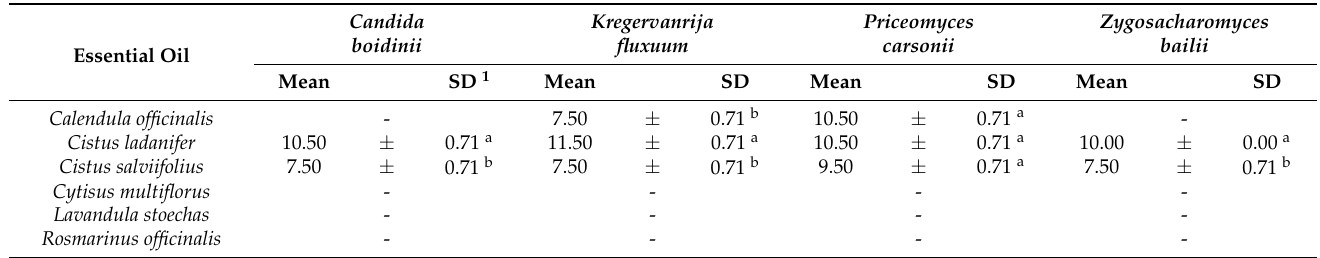
Table 3. Activity of different essential oils obtained from aromatic plants against yeasts, expressed as the diameter of inhibition zones in